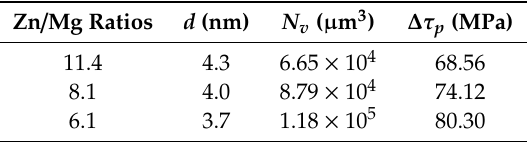
Table 4. Statistical results of precipitation